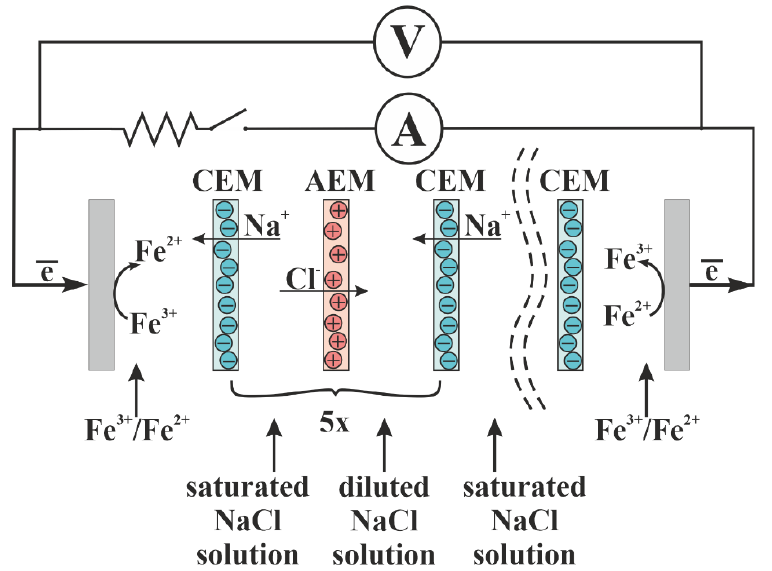
Figure 4. The experimental setup for the RED measurement. “5x” means that this element was repeated 5 times.